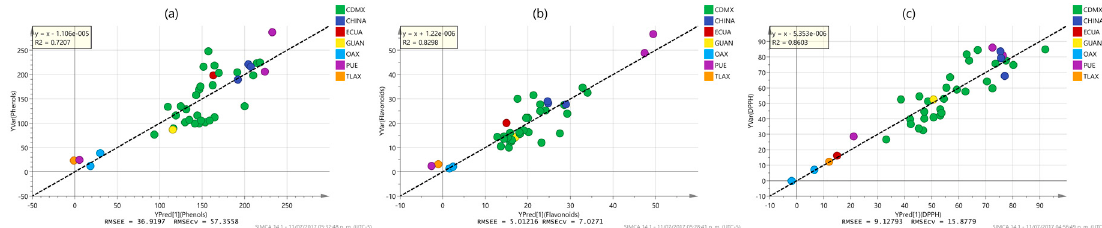
Figure 5. OPLS model observed vs. predicted ( a ) phenol content; ( b ) flavonoid and ( c ) antioxidant (DPPH) content plot of propolis samples labeled according to their origin: Mexico City (CDMX), Puebla (PUE), Oaxaca (OAX), Guanajuato (GUAN), Tlaxcala (TLAX), Ecuador (ECUA) and China (CHINA).